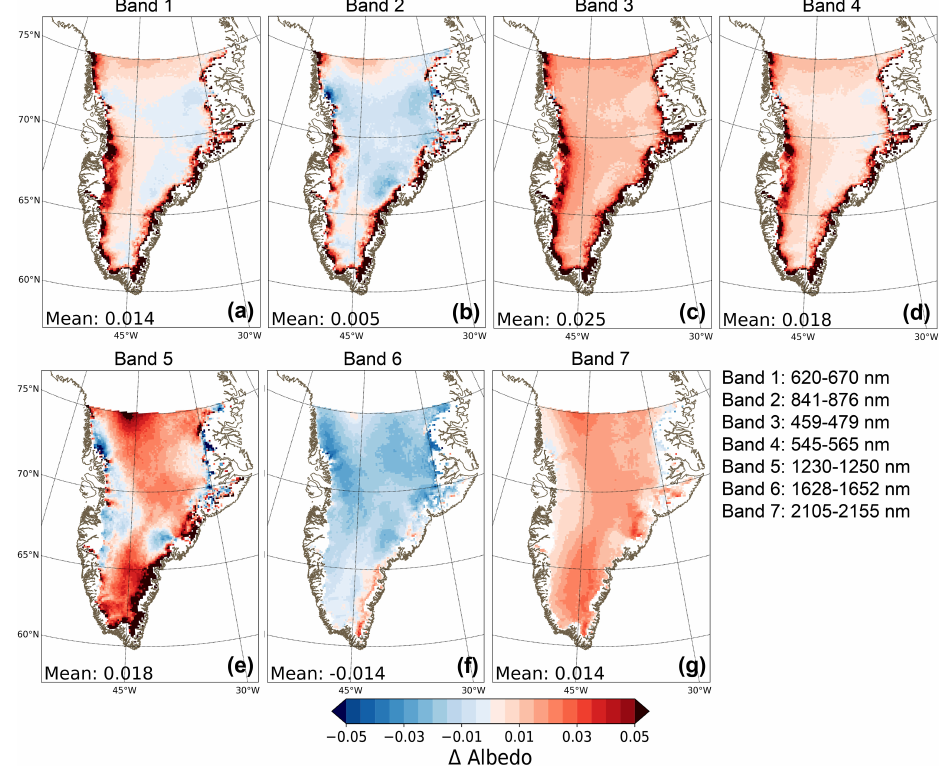
Figure 4. Average albedo difference for 15:00UTC between RACMO2.3p3 16d running mean CSD albedo and MODIS MCD43A3 CSD product, between 2006 and 2015 for (a) band 1 to (g) band 7 (red bands in Fig. 1d). The spectral width of each band is also